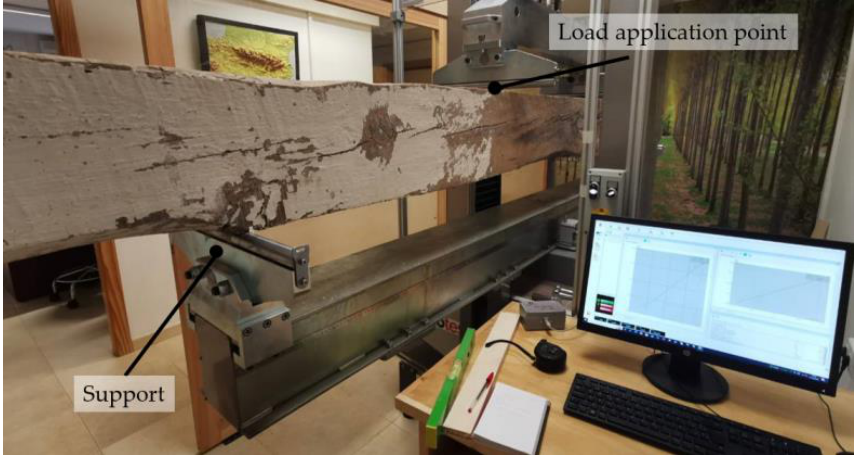
Figure 10. Beam subjected to four-point bending